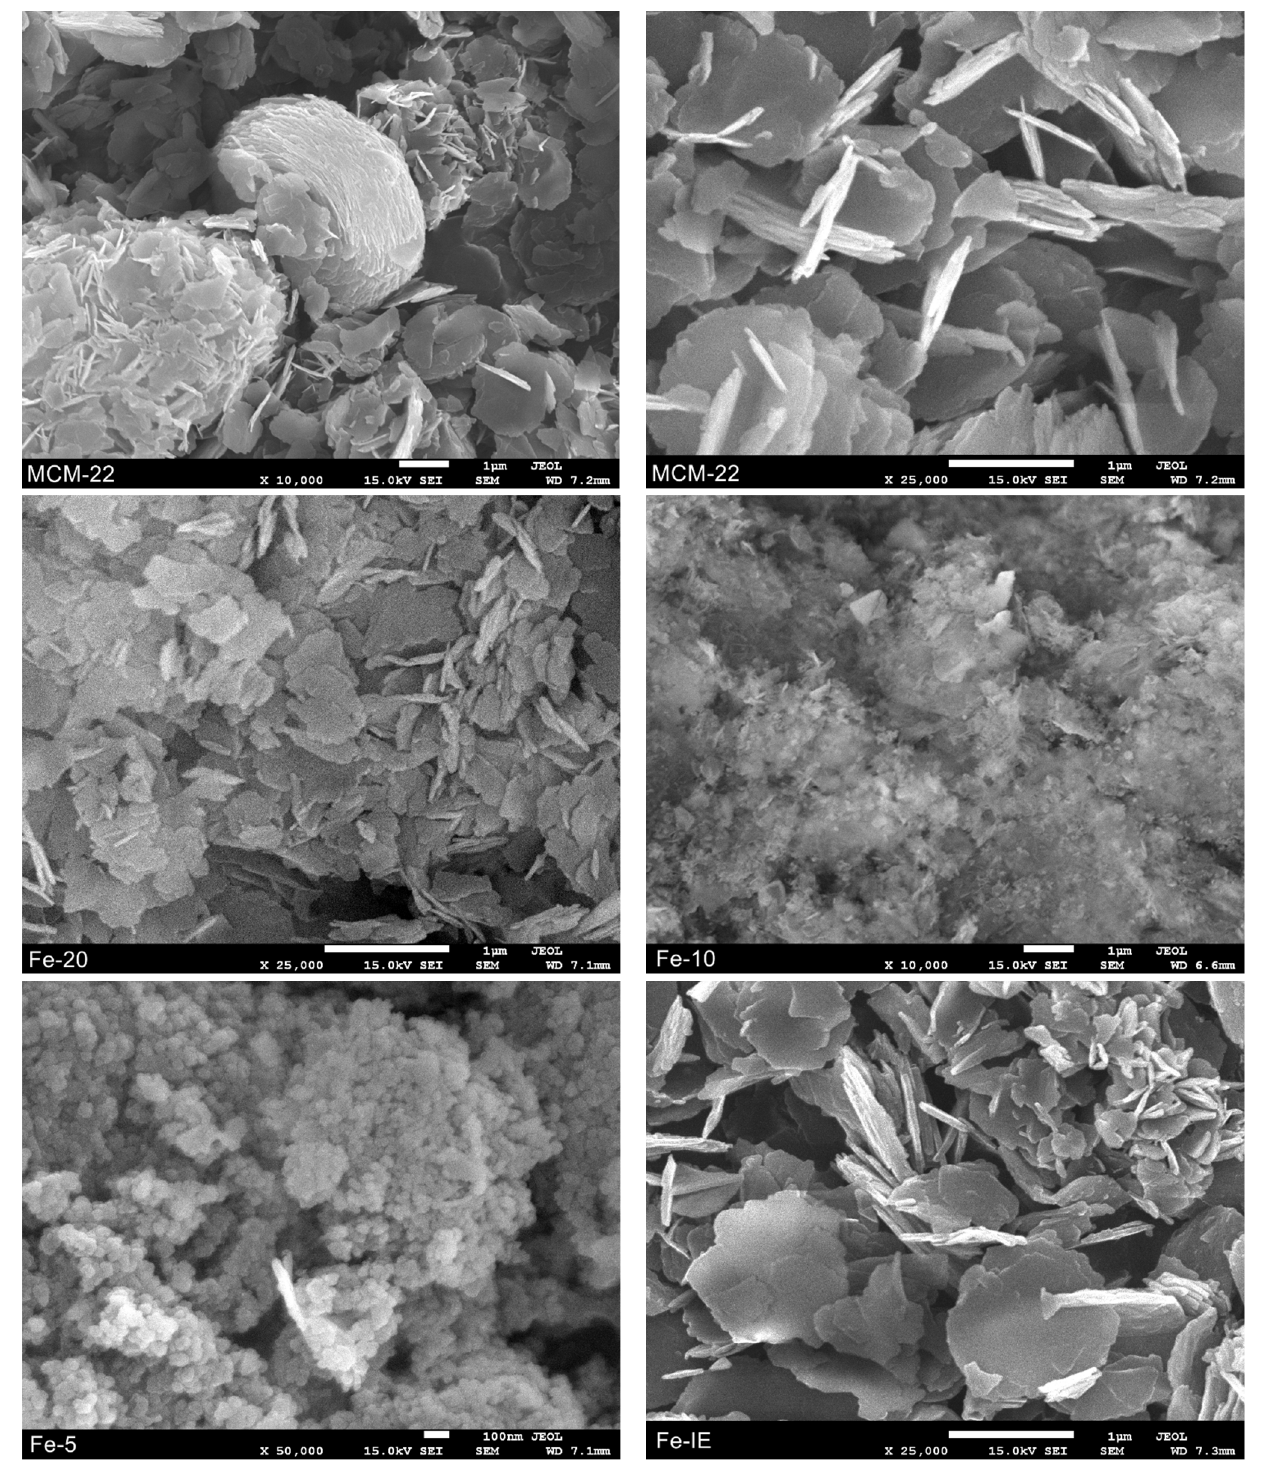
Figure 6. SEM images recorded for MCM-22 and Fe-catalysts. Transmission electron microscopy (TEM) allowed to investigate directly the struc- ture of the layered precursor and the catalysts on a nanoscopic scale. The micrographs recorded for the samples in bright-field (BF), high-angle annular dark-field (HAADF), and high resolution (HR) modes are presented in Figure 7. MCM-22, Fe-IE, and Fe-20 showed a plate-like morphology, due to the presence of ordered, piled MWW-type layers. The layers formed nanoscale crystallites, which can be distinguished into the regular arrays of